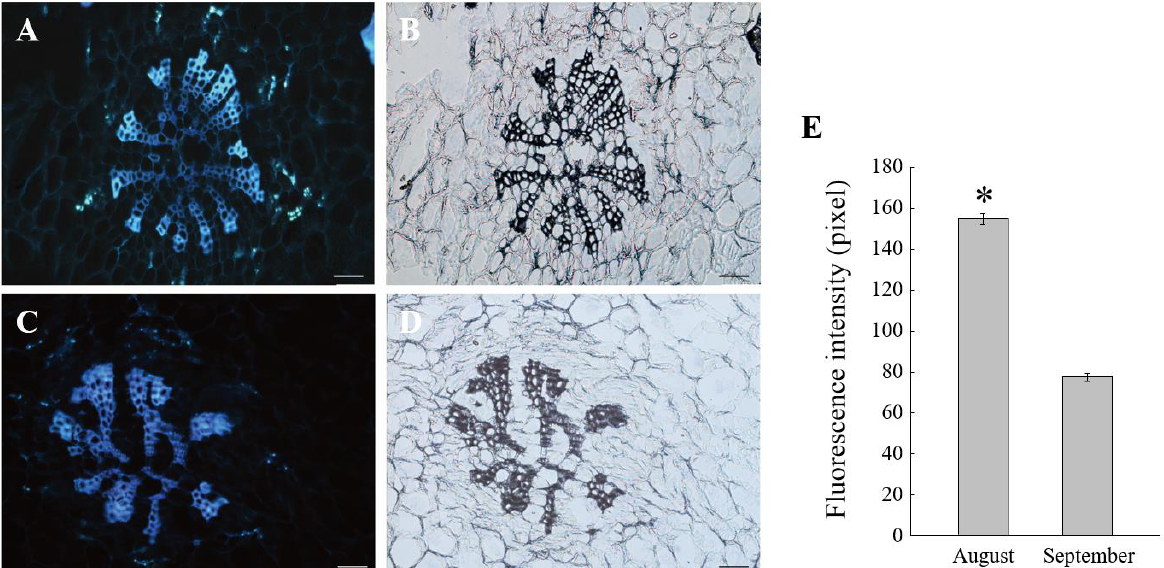
Figure 4. Labelling of cellulose in oil tea fruit pericarp. ( A ) Transverse section of major vascular bundle of oil fruit pericarp in Aug. and ( B ) is the corresponding micrograph in bright field; ( C ) Transverse section of major vascular bundle of oil fruit pericarp in Sep. and ( D ) is the corresponding micrograph in bright field; ( E ) Quantitative analysis of the florescent signal of cellulose in ( A ) and ( C ). Xy, xylem, Ph, phloem. Bar = 100 μm. Asterisk ( p < 0.05) indicate significant differences between two sampling periods.